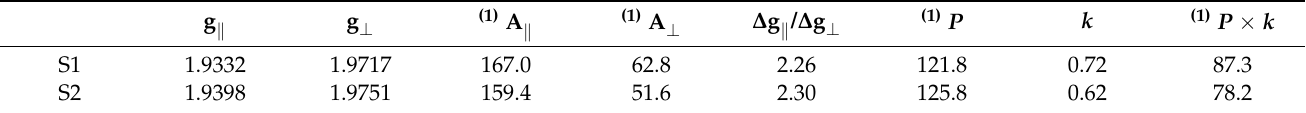
Table 2. Spin Hamiltonian parameters obtained from simulations.